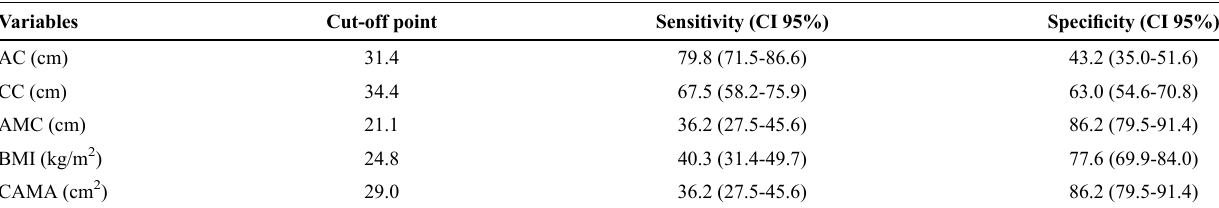
Table 2 - ROC curve parameters of anthropometric indicators of muscle mass used as discriminators of dynapenia in middle-aged and elderly women. Jequié-BA, Brazil, 2017.